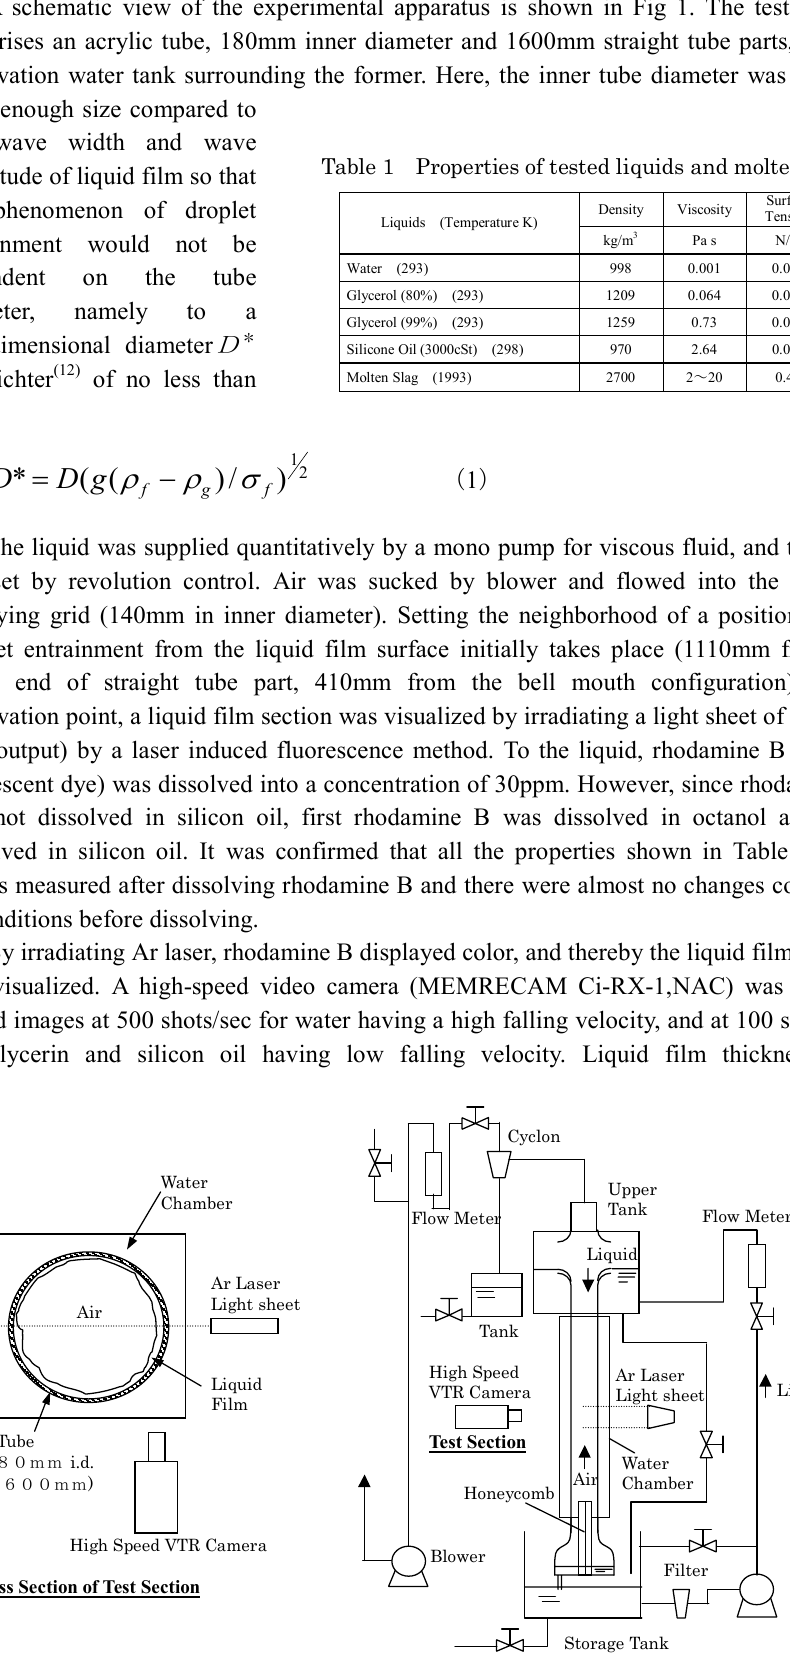
Fig. 1 Schematic of experimental